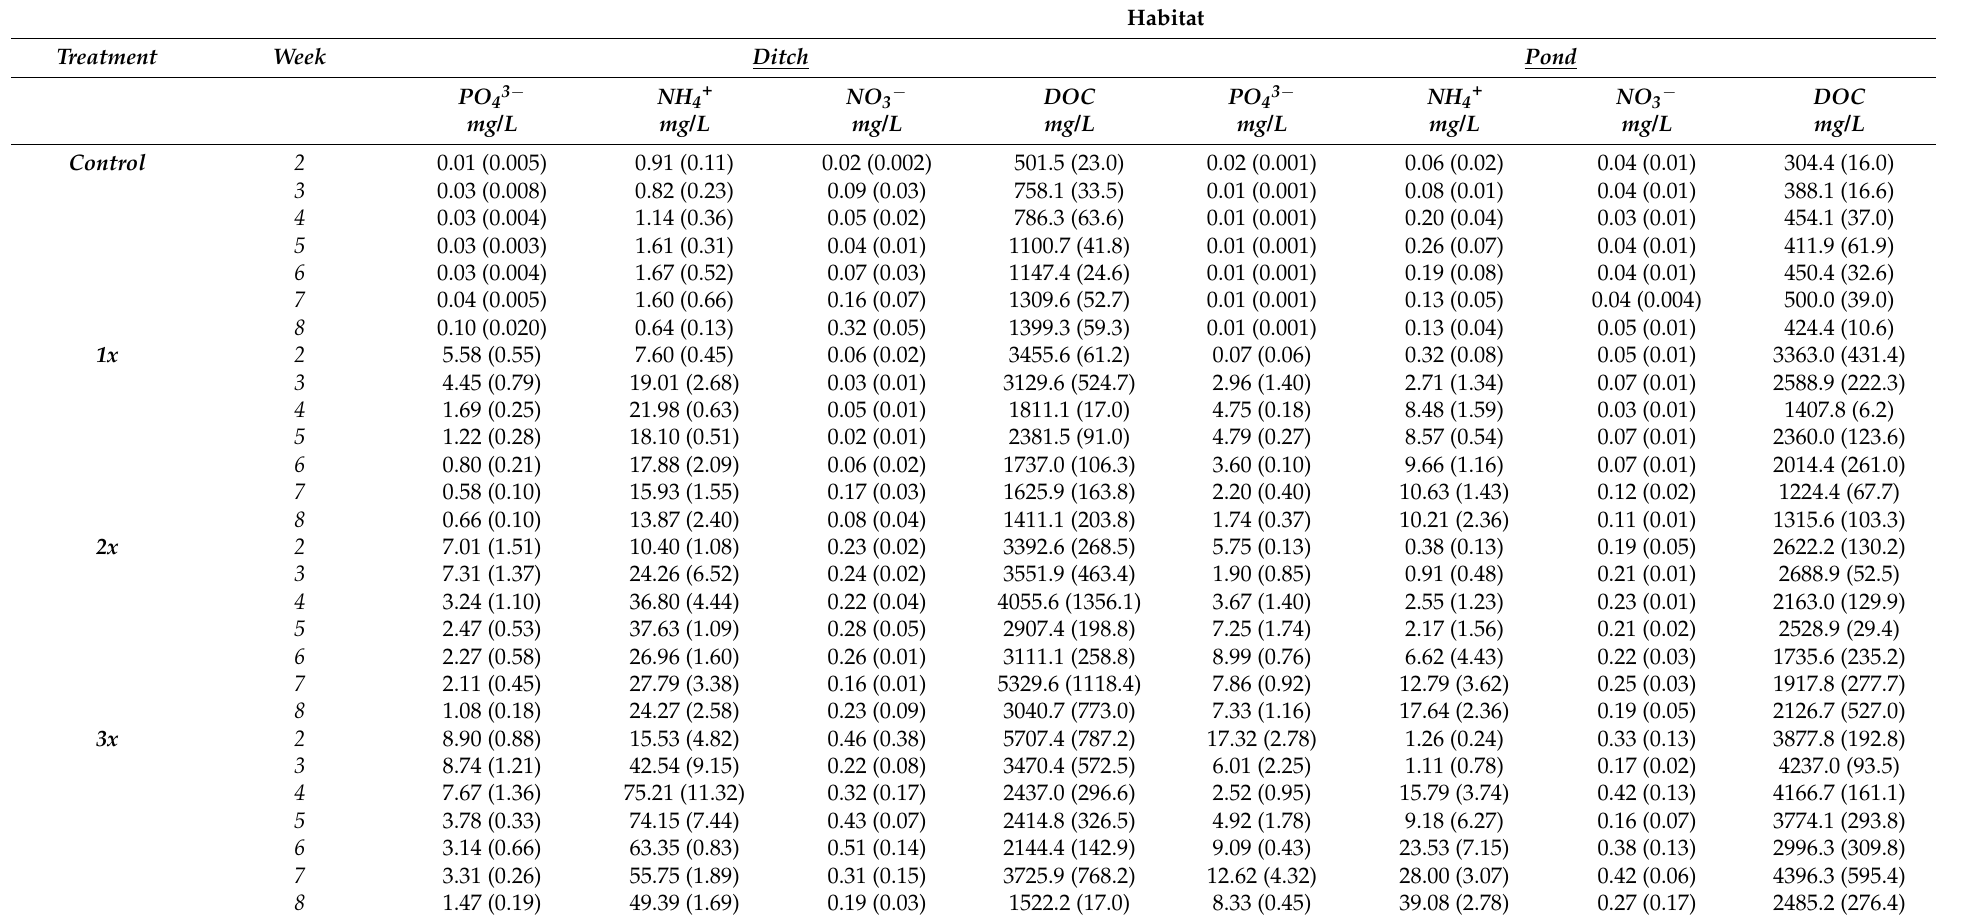
Table 1. Concentrations of each nutrient in each treatment and habitat, n = 3 (Mean ∓ SE).